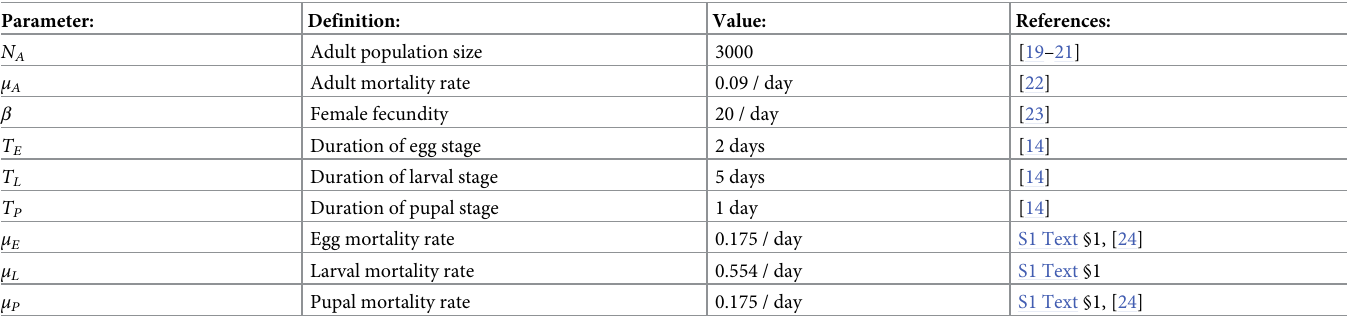
Table 1. Demographic and life history parameters for Aedes aegypti